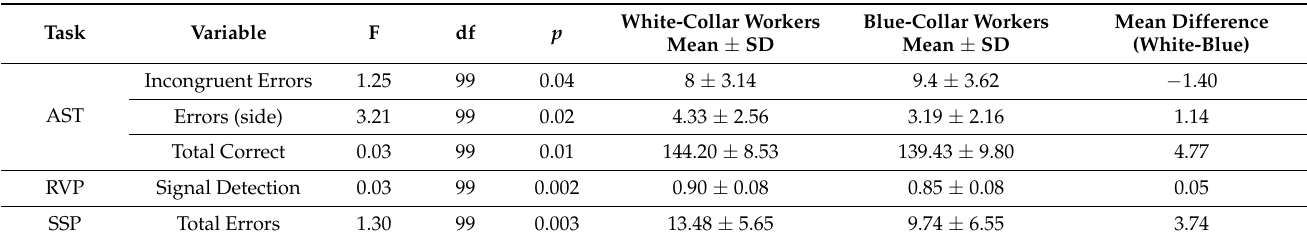
Table 2. Neuropsychological Performance Measures between the Blue ( n = 53) and White-collar ( n = 48) worker sample